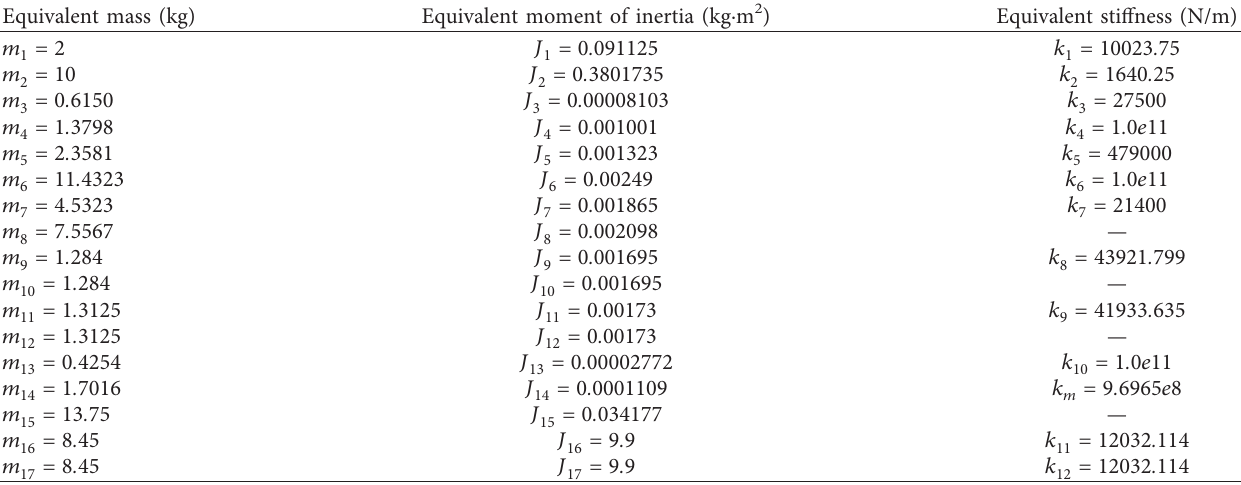
Table 1: The equivalent parameters of powertrain.